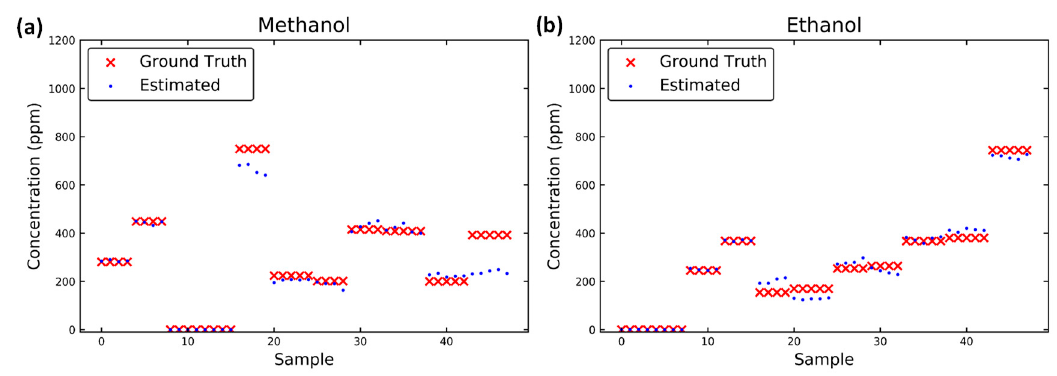
Figure 10. Estimated results for ( a ) methanol and ( b ) ethanol in each sample obtained with the proposed method. The ground truth in red is presented for a comparison with the estimated results.